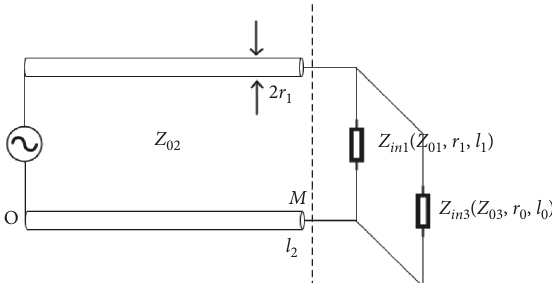
Figure 2: Equivalent circuit diagram of the mid-load whip antenna.